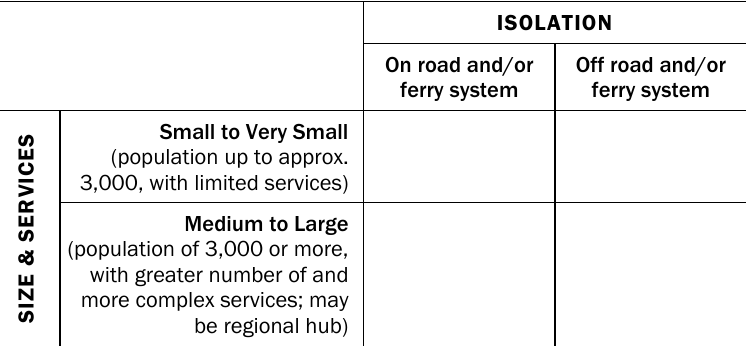
Figure 1. Typology of Rural Alaskan Communities